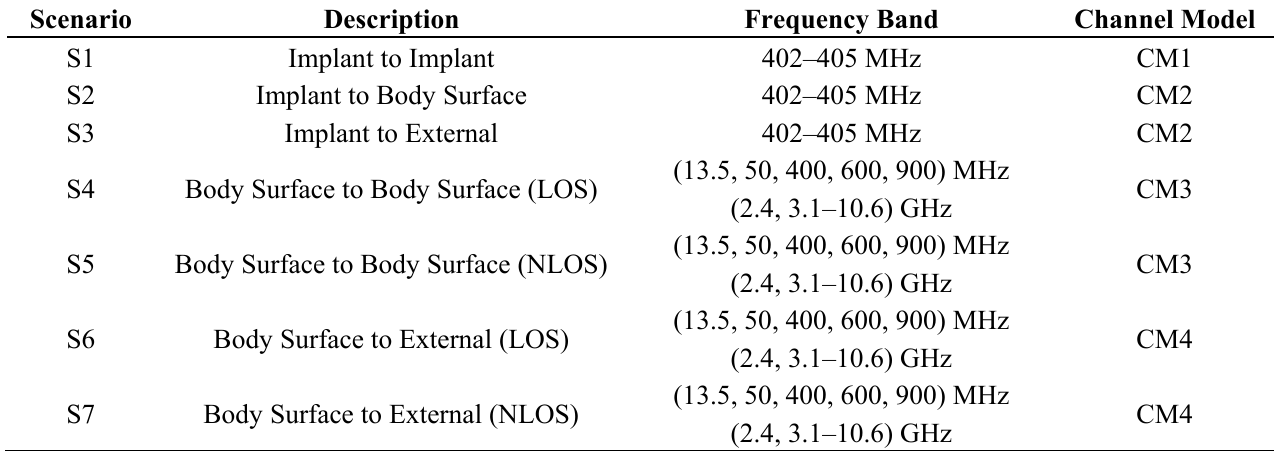
Table 4. Scenarios and description of the IEEE 802.15.6 channel models [31].